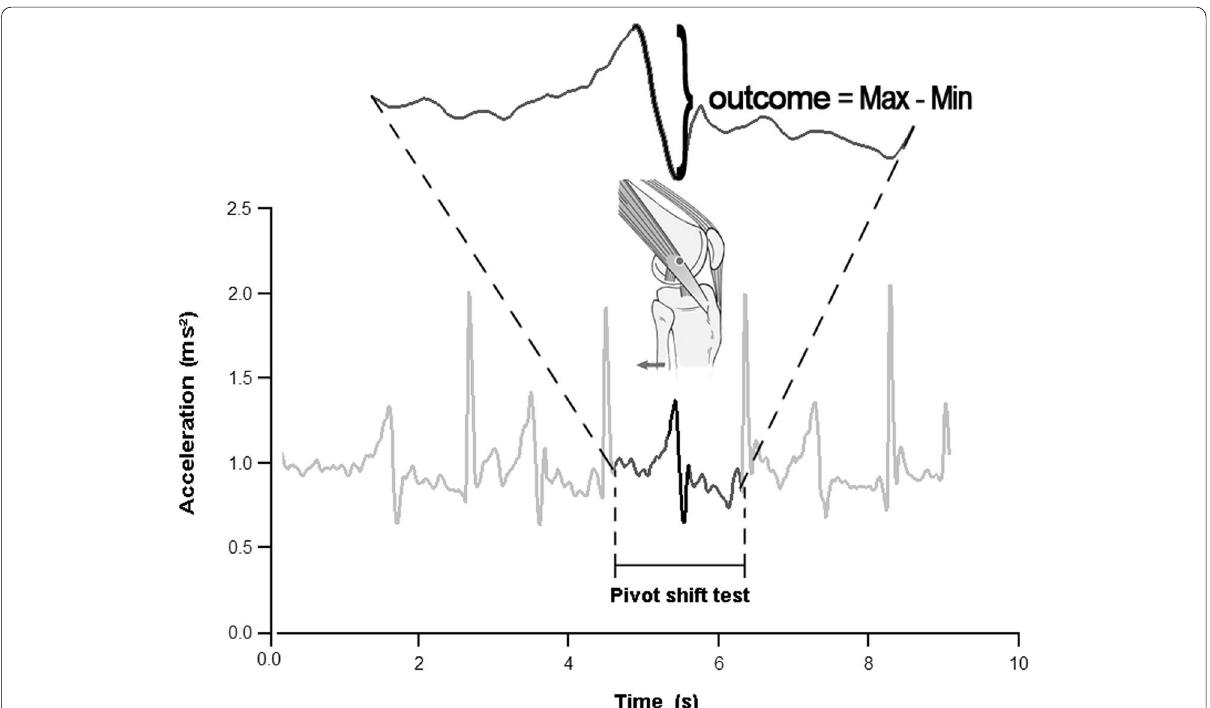
Fig. 2 The acceleration measured during the pivot-shift maneuver resulting in a sudden posterior displacement of the lateral tibial plateau in the reduction